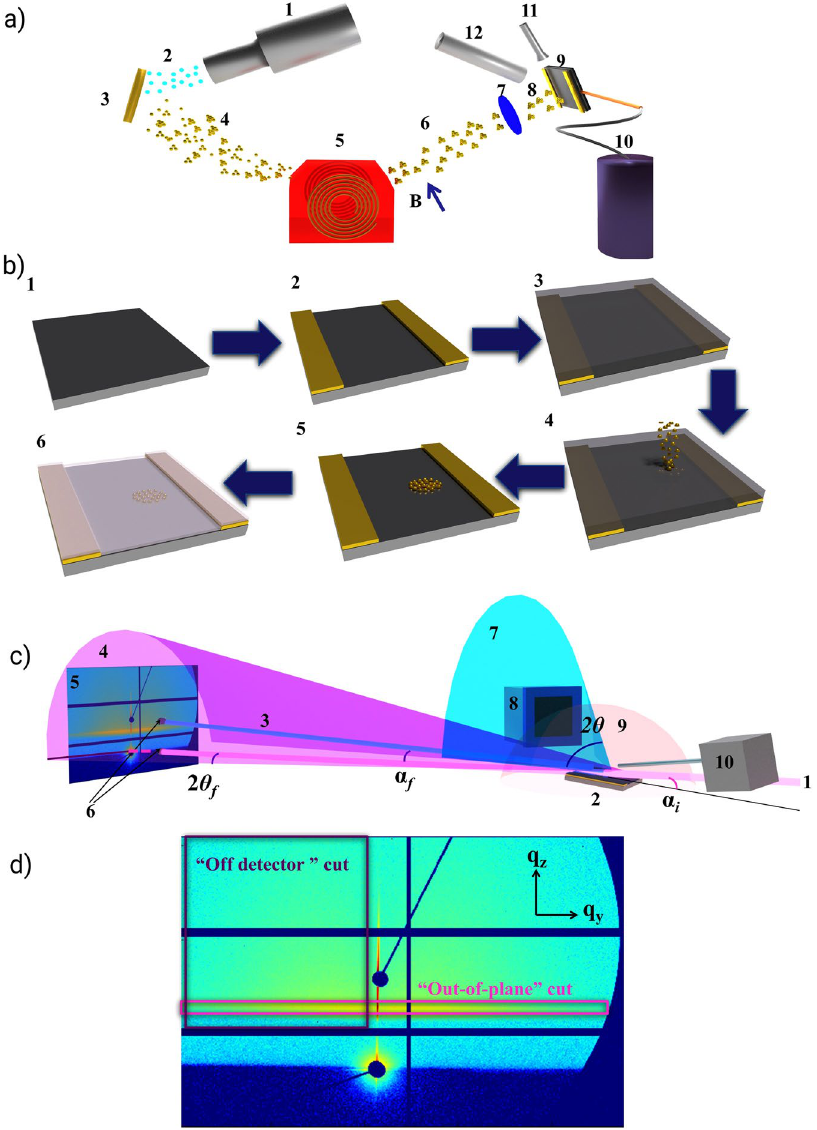
Figure 1. ( a ) Cluster sputtering source ICARUS. 1.Sputter gun. 2. Xe + ions. 3. Au target. 4. Au clusters and adatoms. 5. Dipole magnet for mass selection. 6. Mass-selected clusters or adatoms. 7. Retardation lenses. 8. Mass selected clusters with E kin < 1 eV/atom. 9. Si substrate with Au markers. 10. He cooling for the substrate. 11. Kr gas shower. 12. Evaporator with Al. ( b ) Scheme of the sample preparation. 1. Si substrate 9 × 9 mm 2 . 2. Au markers (2 mm width, 10 nm height) sputtered on the edges. 3. Frozen Kr gas on the surface. 4. Soft landing of Au 9 in Kr matrix in the spot with the radius of 1 mm. 5. Kr matrix removed and clusters landed. 6. Al capping layer evaporated on the system. ( c ) Scheme of the scattering experiment at P03. 1. Synchrotron X-rays. 2. Sample with Au clusters or adatoms. 3. Beam reflected from the sample. 4. Small angle intensity distribution. 5. Resulted GISAXS pattern on the detector Pilatus 1 M (Dectris). 6. Beamstops: primary (bottom), specular (top). 7. Wide angle intensity distribution. 8. GIWAXS detector Pilatus 300 K (Dectris). 9. X-ray fluorescence from the sample. 10. X-ray fluorescence spectrometer Vortex. Angles shown in the scheme: α i – incident angle between the X-ray beam and the sample surface, which is < 1°; α f – exit angle in GISAXS; 2 θ f – out-of-plane angle in GISAXS; 2 θ – exit angle in GIWAXS. ( d ) Scheme of the typical cuts made in GISAXS experiments. In both cases the cuts with maximum q-range are